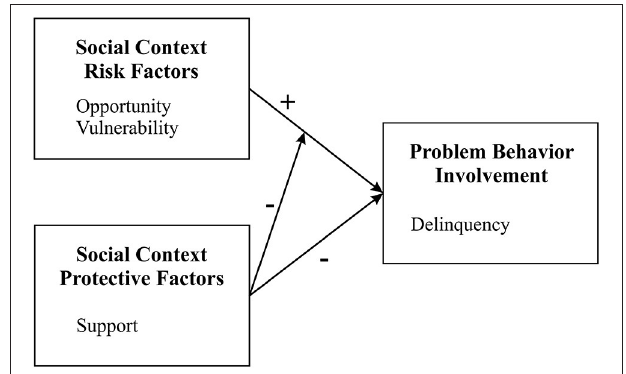
FIGURE 1 | The protection-risk model of social context and adolescent problem behavior involvement (33). The “ + ” and “-” signs indicate a positive or negative impact on problem behavior